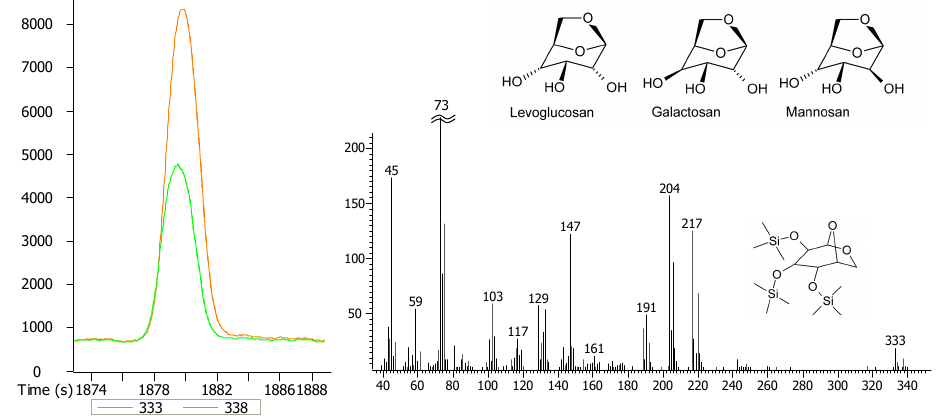
Fig. 4. Levoglucosan: Structural differences of levoglucosan and its isomers (top right). Left side: coelution of silylated native levoglucosan (orange line) and the silylated isotope labelled 13 C 6 -levoglucosan (green line) in the chromatogram. Right side: The mass spectra of the chromatogram at maximum of the isotope labelled